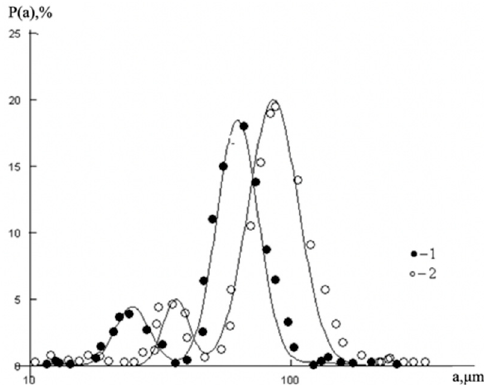
Figure 1. Emulsion particle size distribution within mixing after time 1–10 min; 2–20 min